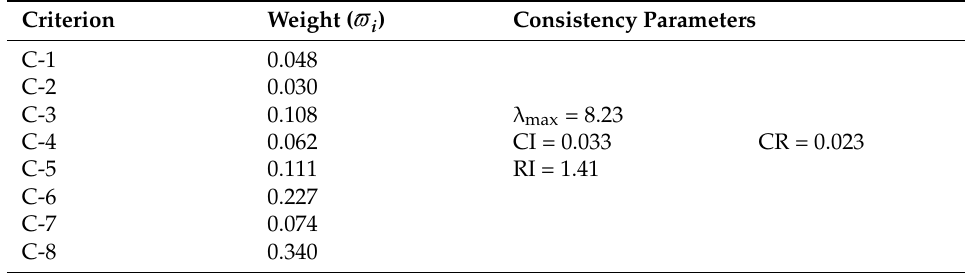
Table 4. Results of AHP